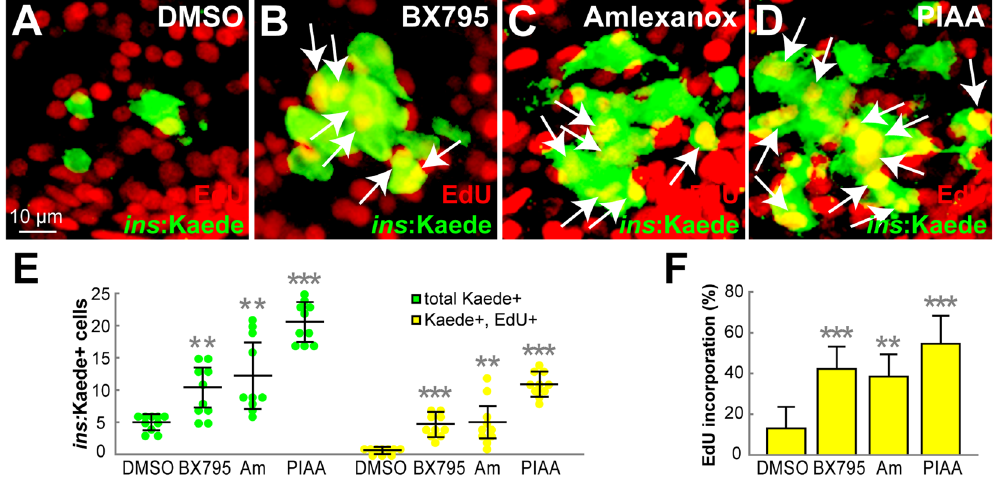
Figure 3. TBK1/IKK ε inhibitors promote β -cell replication. ( A – D ) Confocal images of [ Tg ( ins : CFP-NTR ) s892 ; Tg ( ins : Kaede ) jh6 ] larvae at 48 hpa, concurrently treated with EdU and DMSO ( A ), BX795 ( B ), amlexanox ( C ), or PIAA ( D ), respectively, from 0–48 hpa. The number of β -cells that incorporated EdU (white arrows) was substantially increased in TBK1/IKK ε -I-treated recovering larvae ( B–D ) compared to DMSO-treated larvae ( A ). ( E ) Quantification of the number (mean ± SD) of total regenerated β -cells (green) and regenerated β -cells that incorporated EdU (yellow) at 48 hpa (in A-D; 5.0 ± 1.3 total regenerated β -cells, of which 0.7 ± 0.5 (DMSO), 11.0 ± 3.4, of which 4.6 ± 1.8 (BX795), 12.8 ± 4.8, of which 5.2 ± 2.8 (amlexanox), and 20.6 ± 3.1, of which 11.0 ± 1.9 (PIAA) incorporated EdU). ( F ) The percentage (mean ± SD) of regenerated β -cells that incorporated EdU at 48 hpa (in A-D; 13.0 ± 11.0% (DMSO), 42.0 ± 5.0% (BX795), 39.0 ± 7.0% (amlexanox), and 55.0 ± 14.0% (PIAA)). Cells in 20 planes of confocal images from 10 individual larvae were counted per condition. ** P < 0.01; *** P <